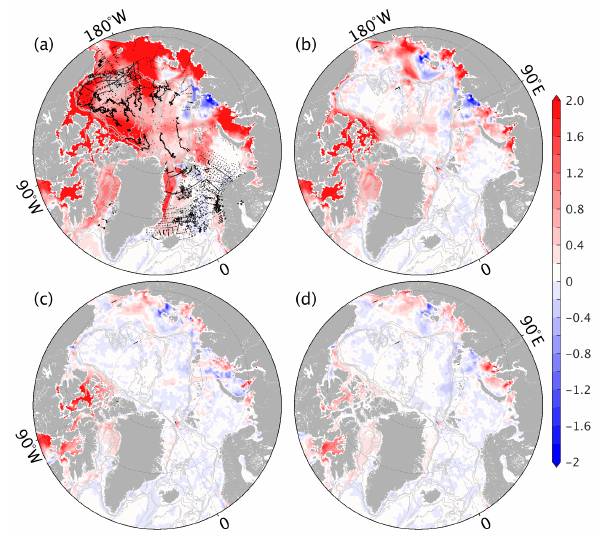
Figure A1. Example of sea surface salinity difference between (a) the background and the truth, (b) the analysis with a decorre- lation radius of 300km and the truth, (c) the analysis with a decor- relation radius of 1000km and the truth, and (d) the analysis with a decorrelation radius of 2400km and the “truth”. Black dots in panel (a) denote the locations of synthetic observations, sampled using sites of the observations from the year